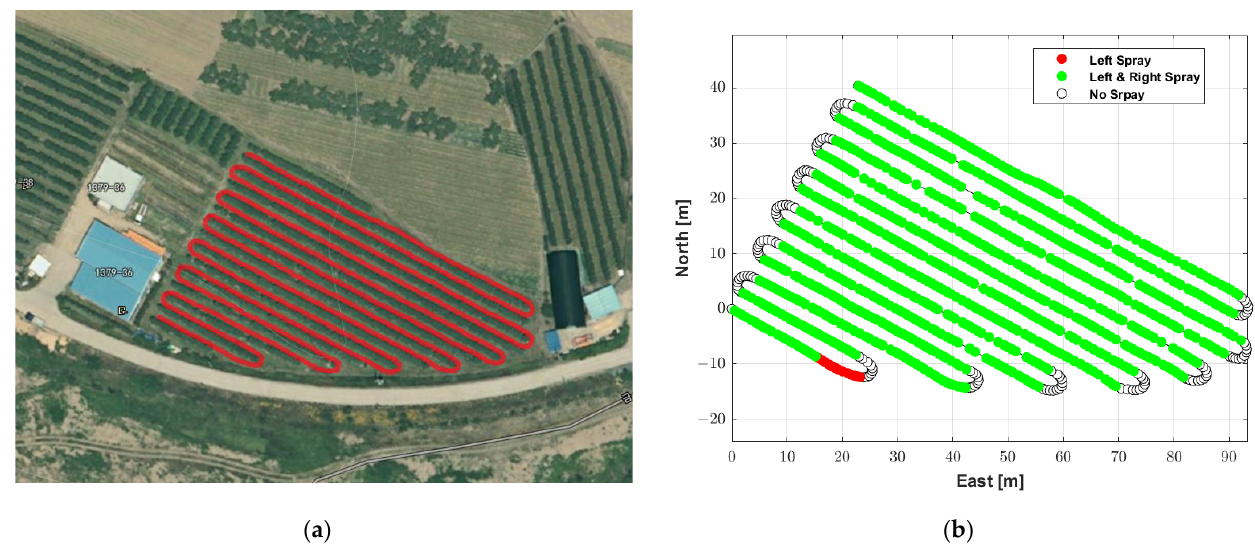
Figure 8. Autonomous driving trajectory used to evaluate the autonomous driving performance. ( a ) Autonomous driving trajectory, ( b ) waypoints with spraying direction. ( a ) Autonomous driving trajectory, ( b ) waypoints with spraying